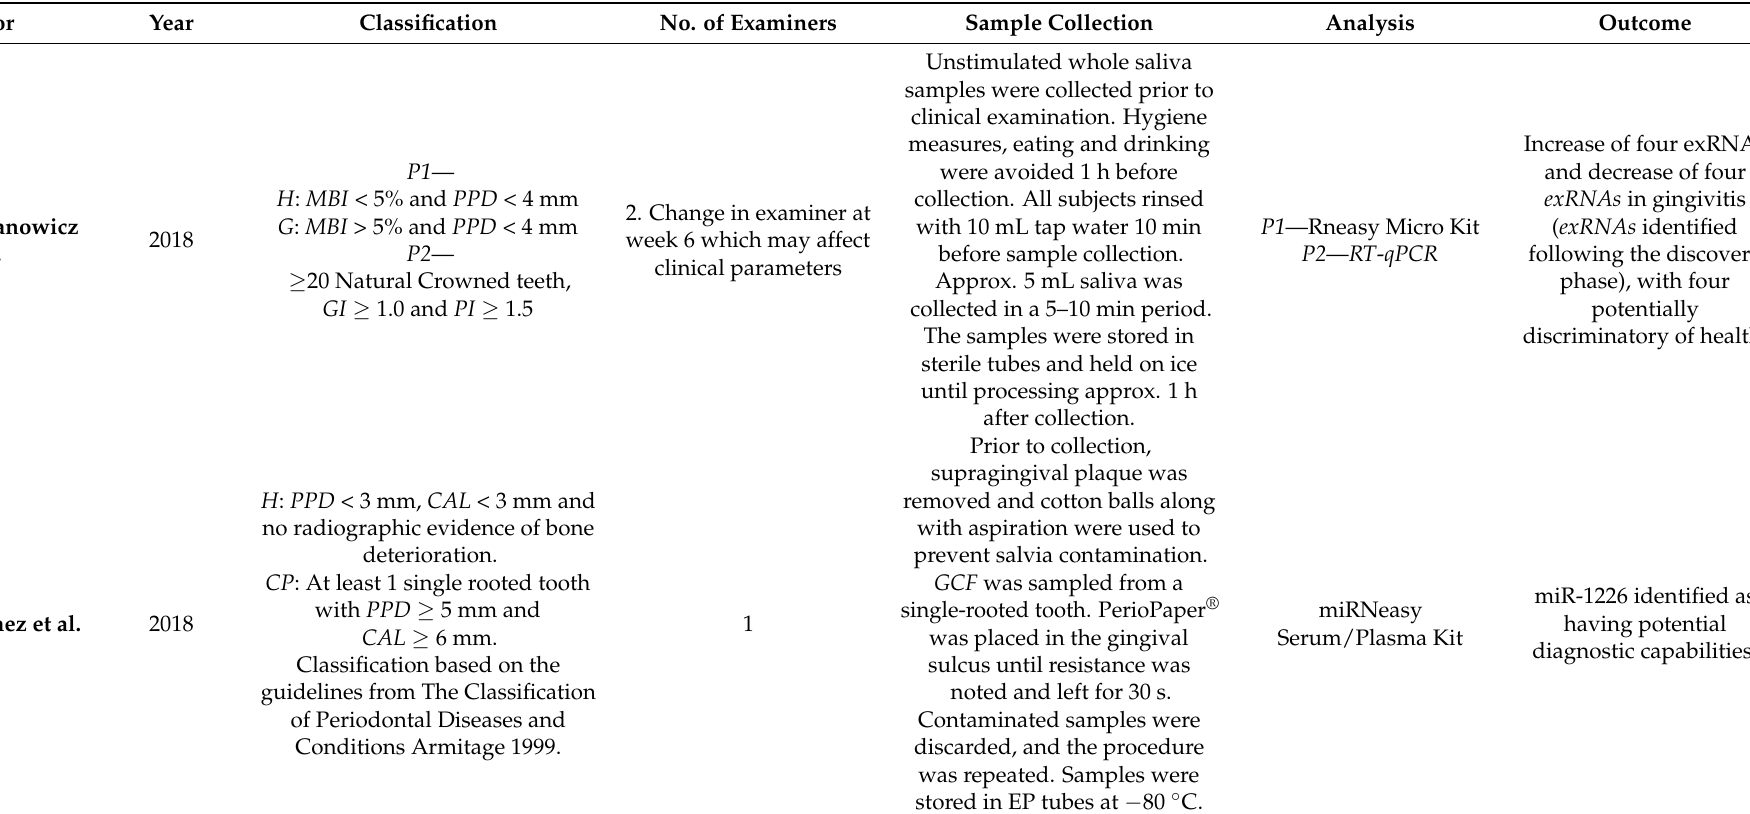
Table 6. Disease classification, number of examiners, sample collection method, sample analysis technique and brief outcome of studies analyzing RNA